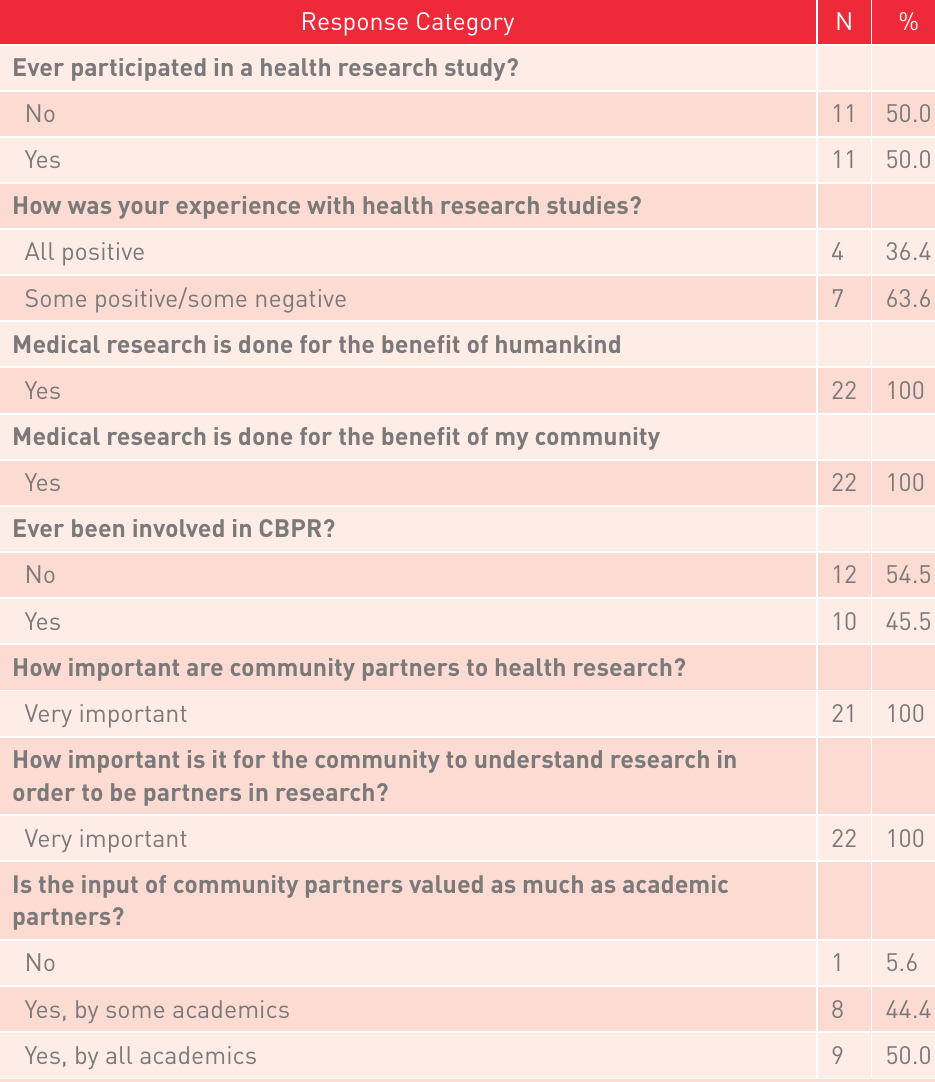
Participants’ Attitudes and Experiences Related to Health Research Response